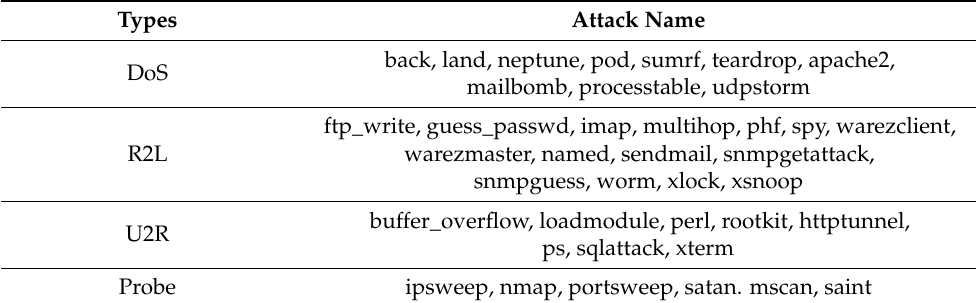
Figure 2. Common dataset of the network intrusion detection system [16]. Table 1. The attack types of the NSL-KDD